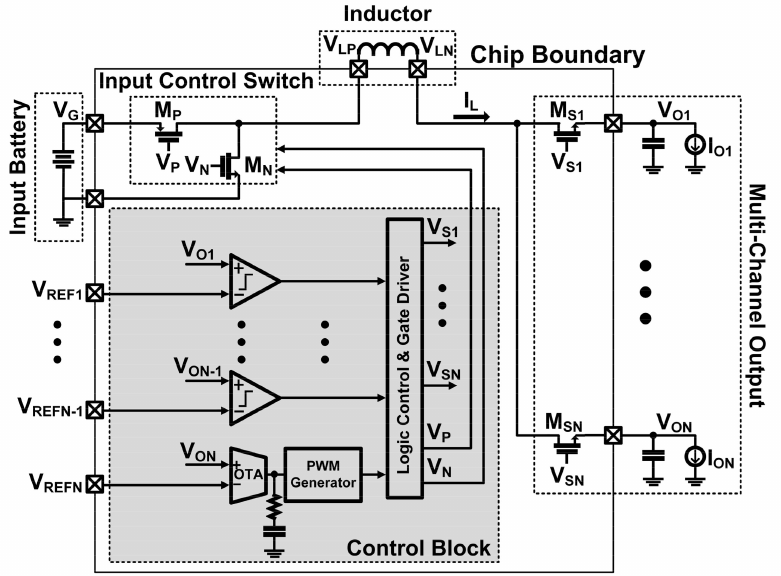
Figure 1. Simplified block diagram of the OPDC method with N multi-channel